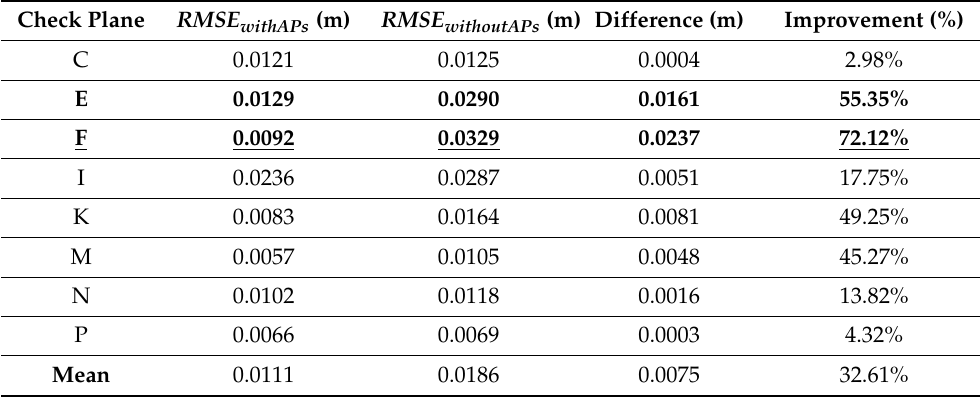
Table 7. RMSE of each check